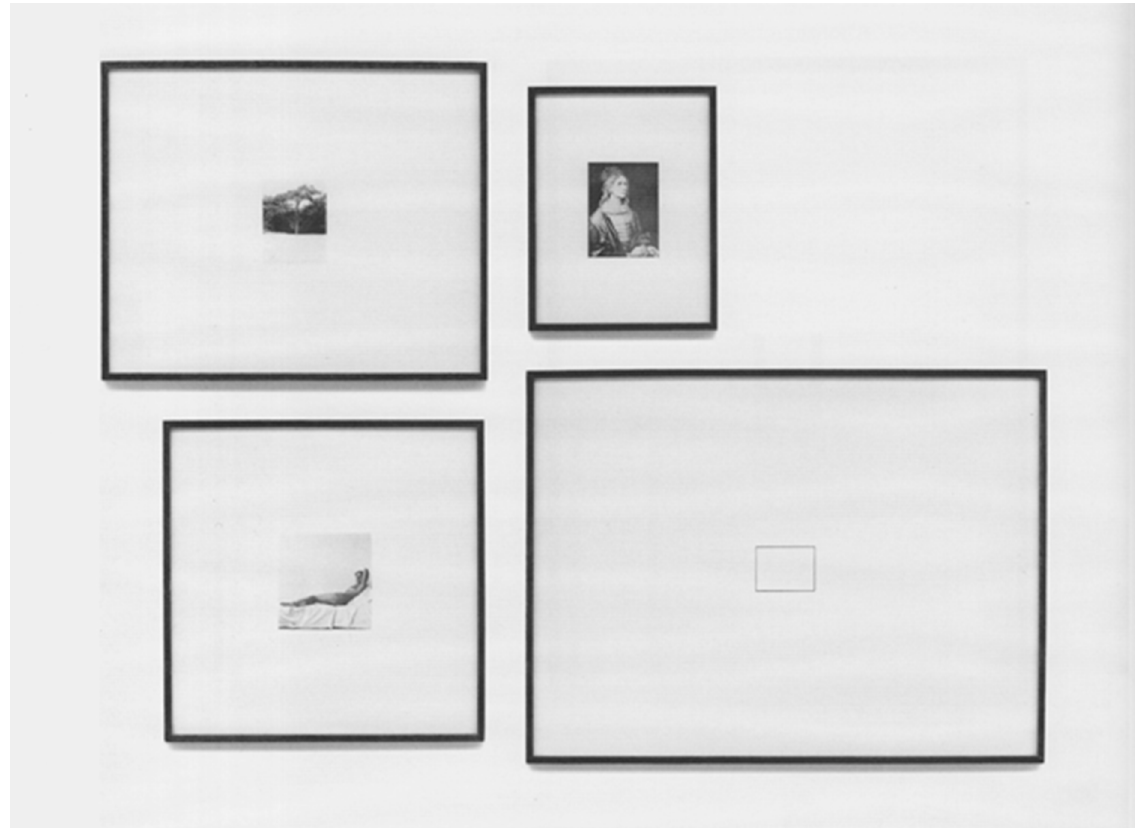
Figure 1. Jozefien van Beek, “Museum M opent dialoog tussen oude en hedendaagse kunst,” De Figure 4. Jan Vercruysse, Zonder Titel (Zelfportretten) III , 1979. Work in four parts, photolitho print on Morgen 22 September 2008. In the margins, Jan Vercruysse highlighted the passage in which paper. Measurements, clockwise beginning top left: 36 × 44 cm; 27 × 21 cm; 36.4 × 36.5; 45 × 60 cm. Veronique Vandeckerchove compares him with the Flemish Primitives. (Brussels: Jan Vercruysse Photo: Dirk Pauwels. Reprinted with permission from Jan Vercruysse Foundation).